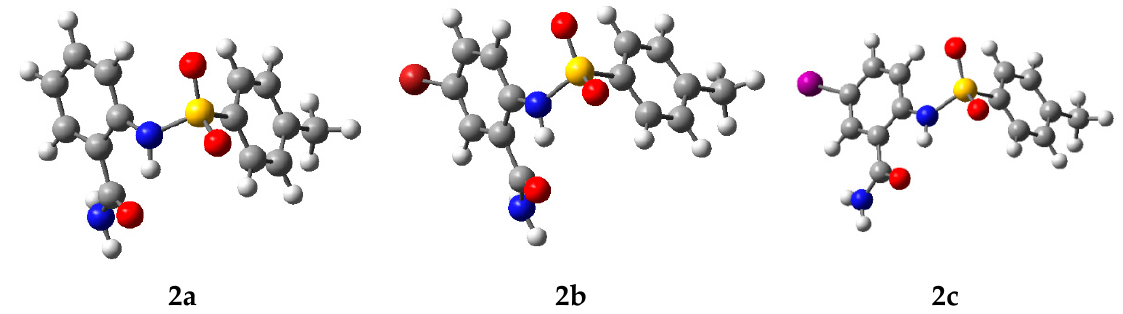
Figure 4. Optimized structures of 2a , 2b and 2c in the gas phase. The Highest Occupied Molecular Orbital (HOMO) and Lowest Unoccupied